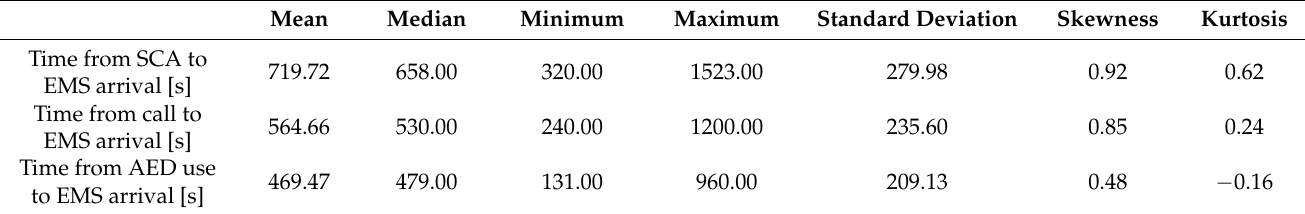
Table 7. Basic descriptive statistics on the number of the quantitative variables studied regarding EMS